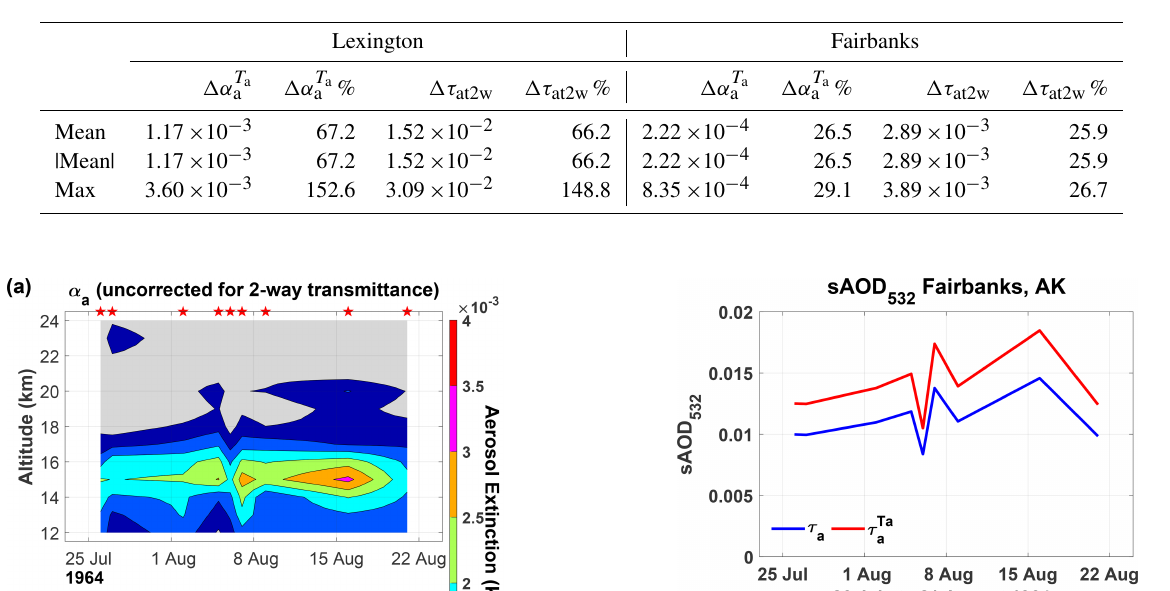
Table 3. The same as Table 2 but for the comparison of α a (532 ,z ) ∗ vs. α T a a (532 ,z ) and τ a ∗ vs. τ T a a . See text for details.